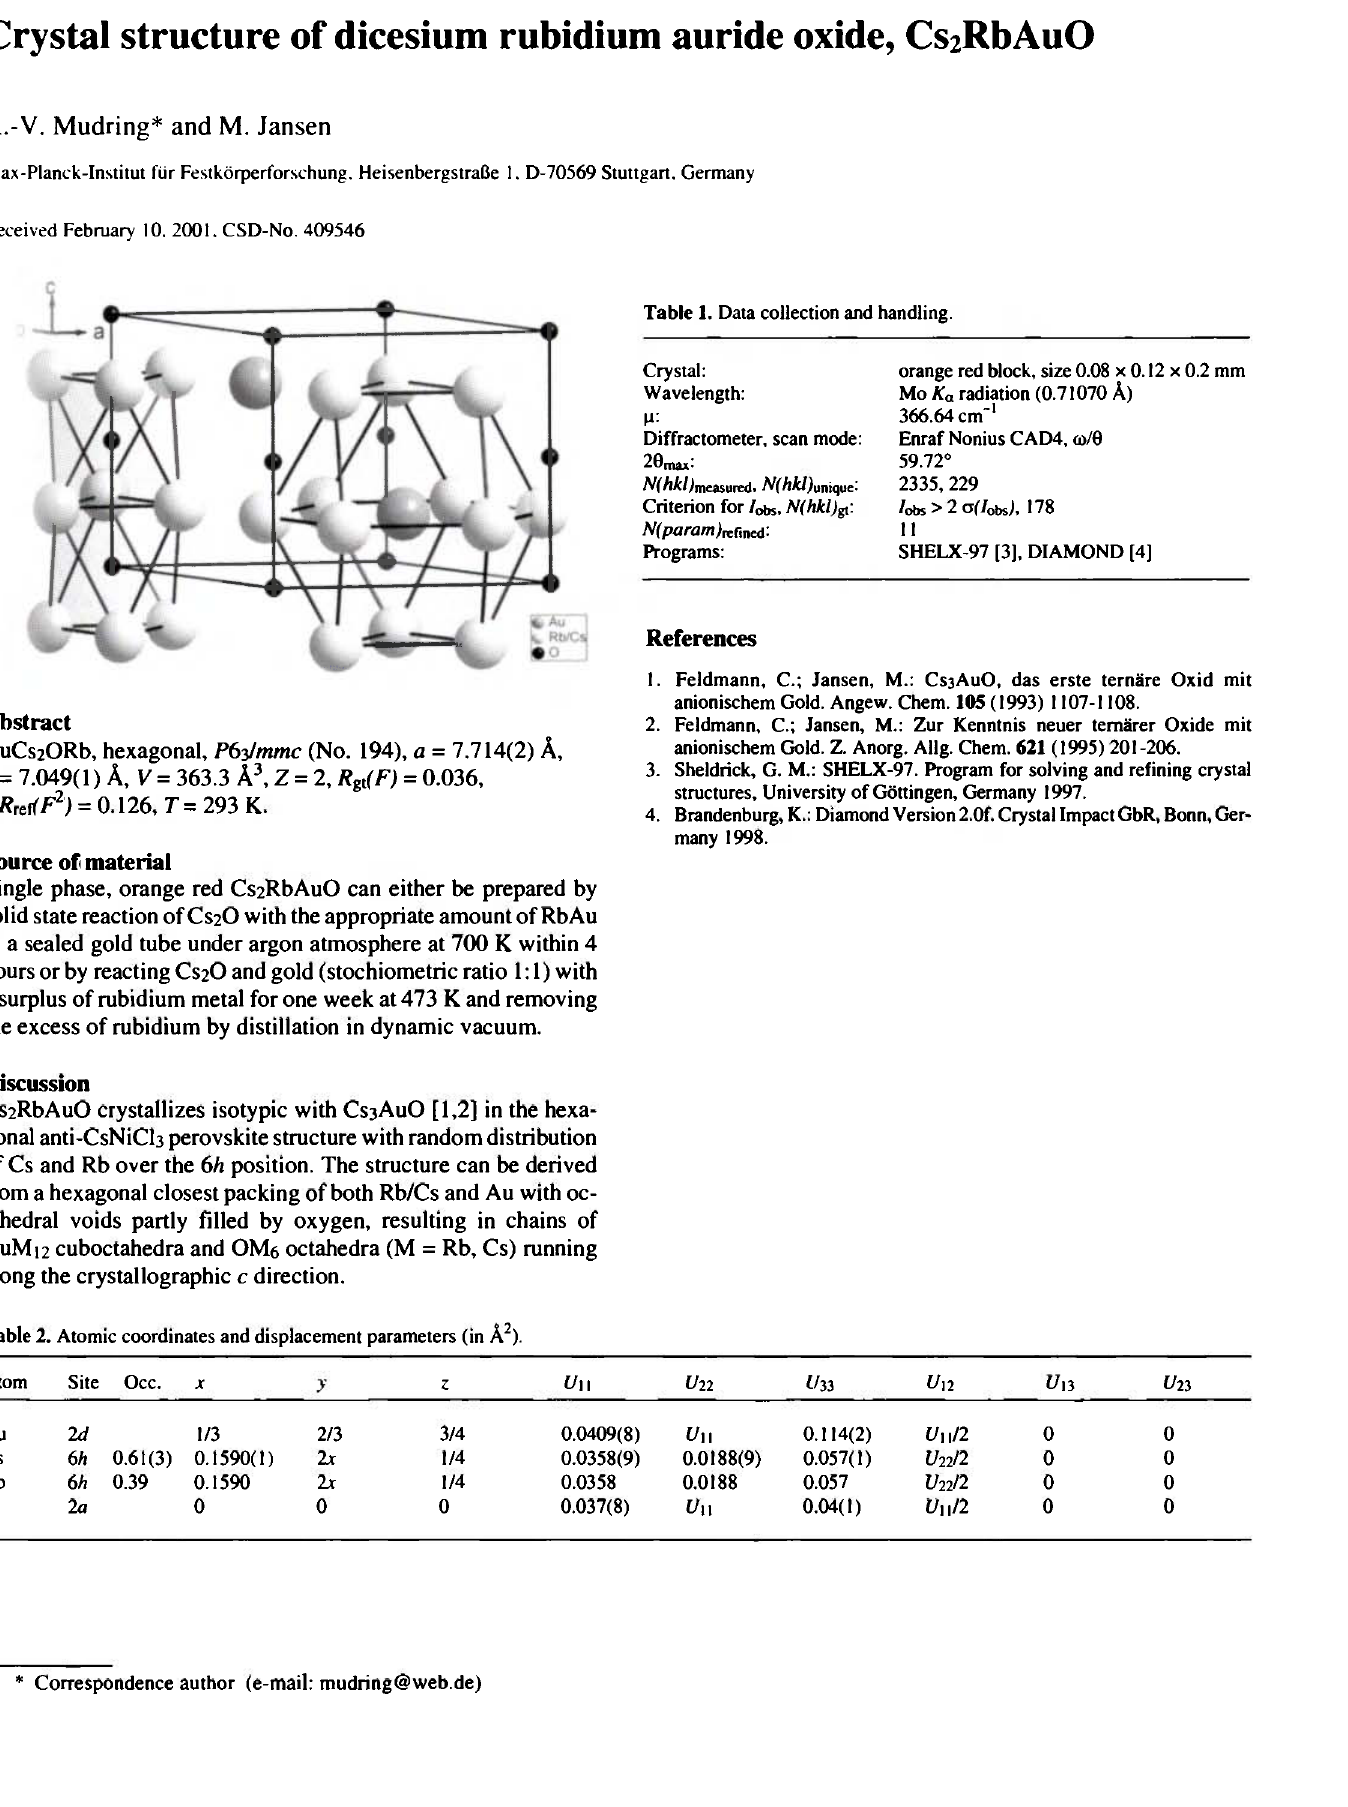
Table 1. Data collection and handling. Crystal: